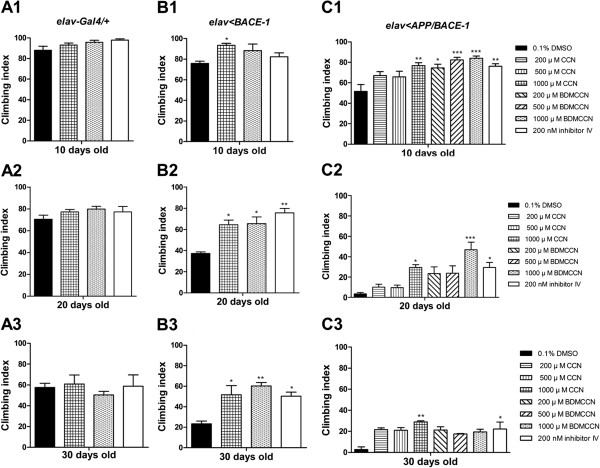
Effect of curcumin, bisdemethoxycurcumin, and β-secretase Inhibitor IV supplementation on climbing behavior of 10, 20, and 30 days old male flies from elav-Gal4/+ (A), elav < BACE-1 (B), and elav < APP/BACE-1 (C) (n = 50–100 flies. (***: p < 0.001, **: p < 0.01, *: p < 0.05). Each bar represents standard error.